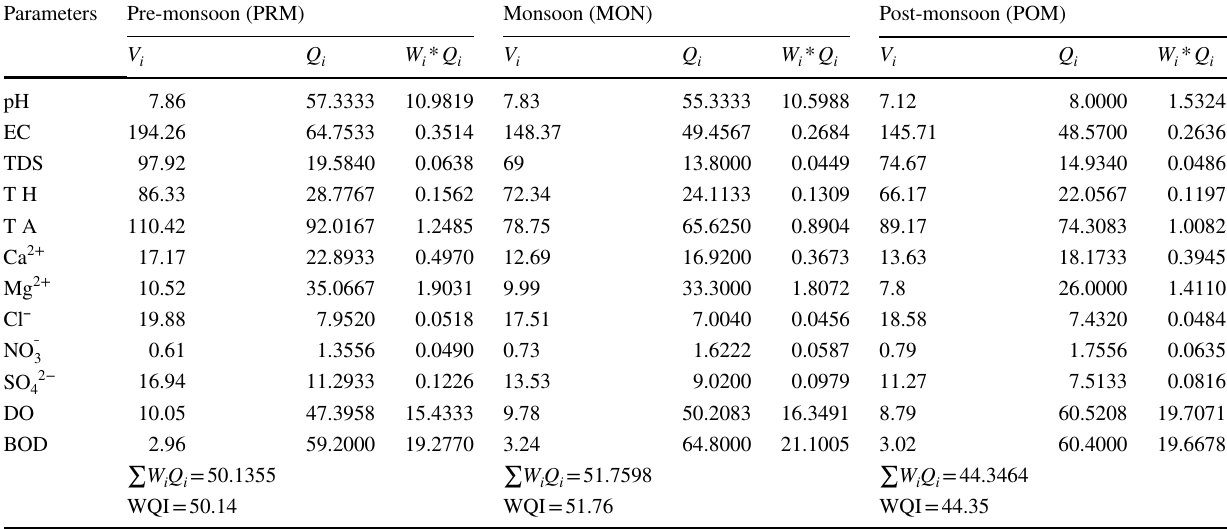
Table 6 Calculation of WQI at station 2 (S 2) Parameters